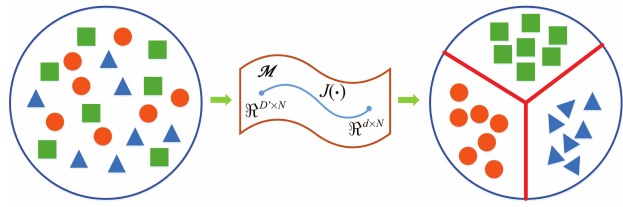
Figure 4. Schematic diagram of the discrimination manifold